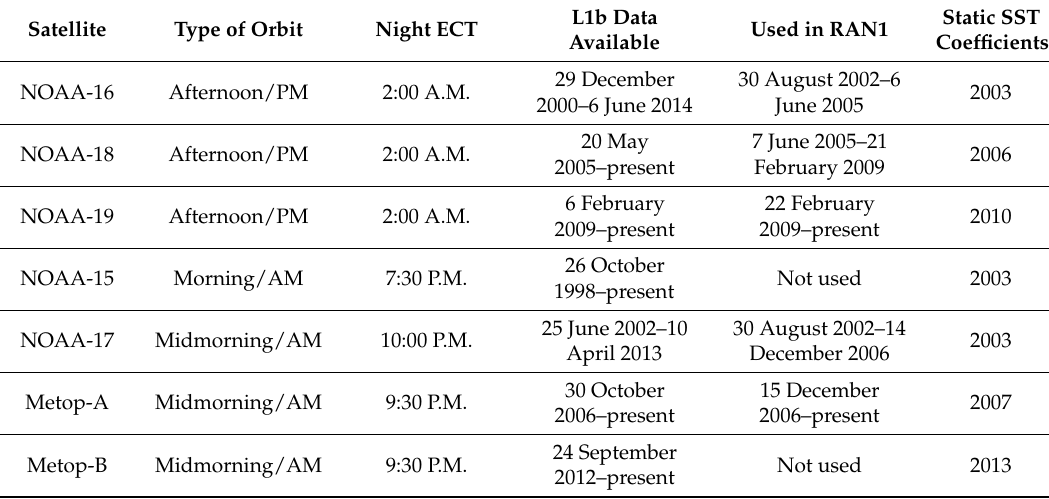
Table 1. The Advanced Very High Resolution Radiometer (AVHRR)/3 Global Area Coverage (GAC) data analyzed in this study and a subset used in Reanalysis version 1 (RAN1). The Equator Crossing Time (ECT) of the nighttime satellite pass, and the year from which static sea surface temperature (SST) regression coefficients were derived, are also